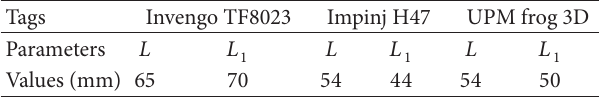
Figure 7: Simulated reflection coefficient of the proposed antenna with different sizes of the feed loop. Table 3: Dimensions of the three commercial tag antennas.